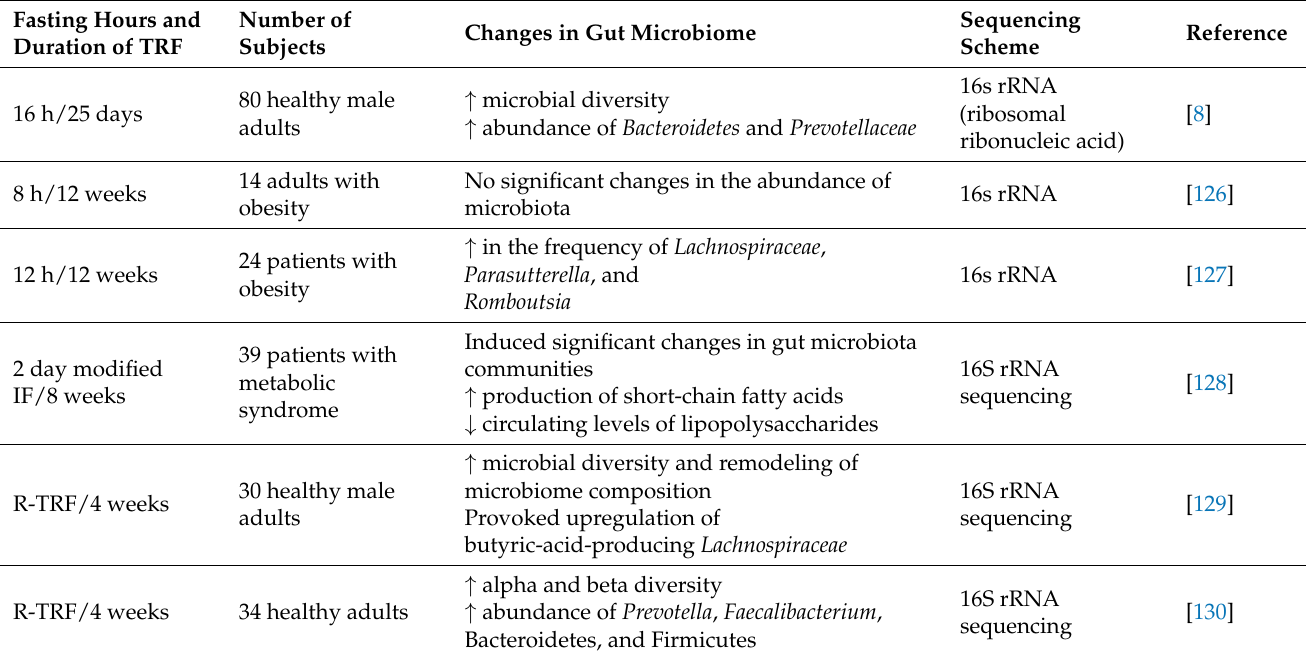
Table 1. TRF-induced changes in the gut microbiome: evidence from human